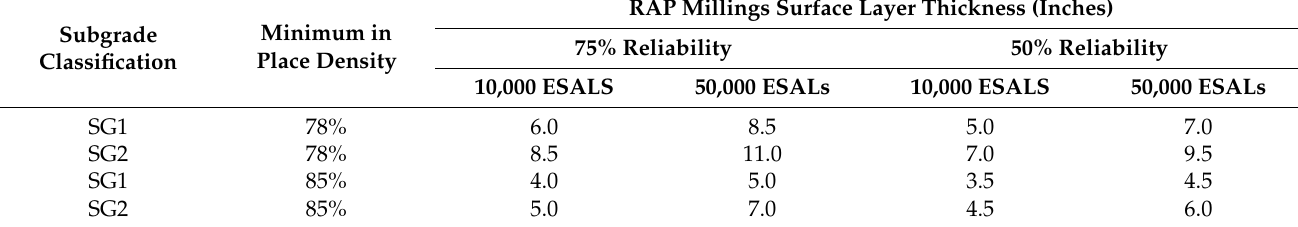
Table 9. RAP millings surface layer